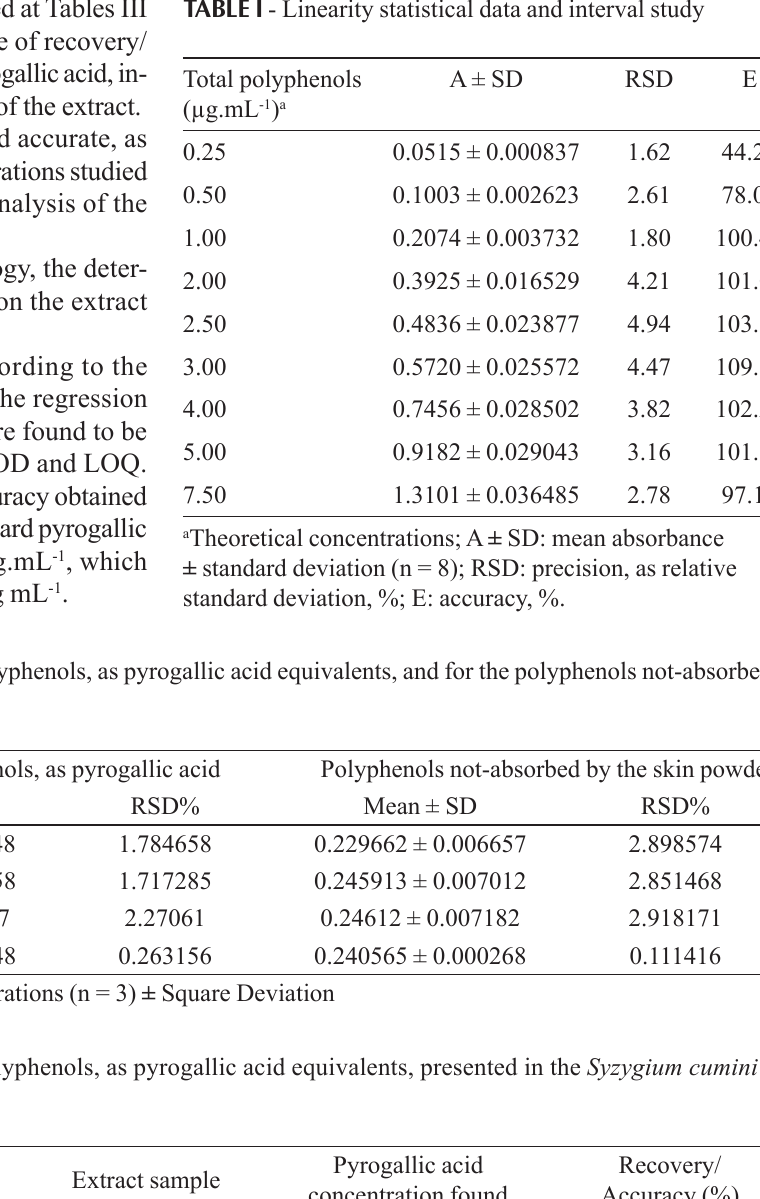
TaBLe I - Linearity statistical data and interval study